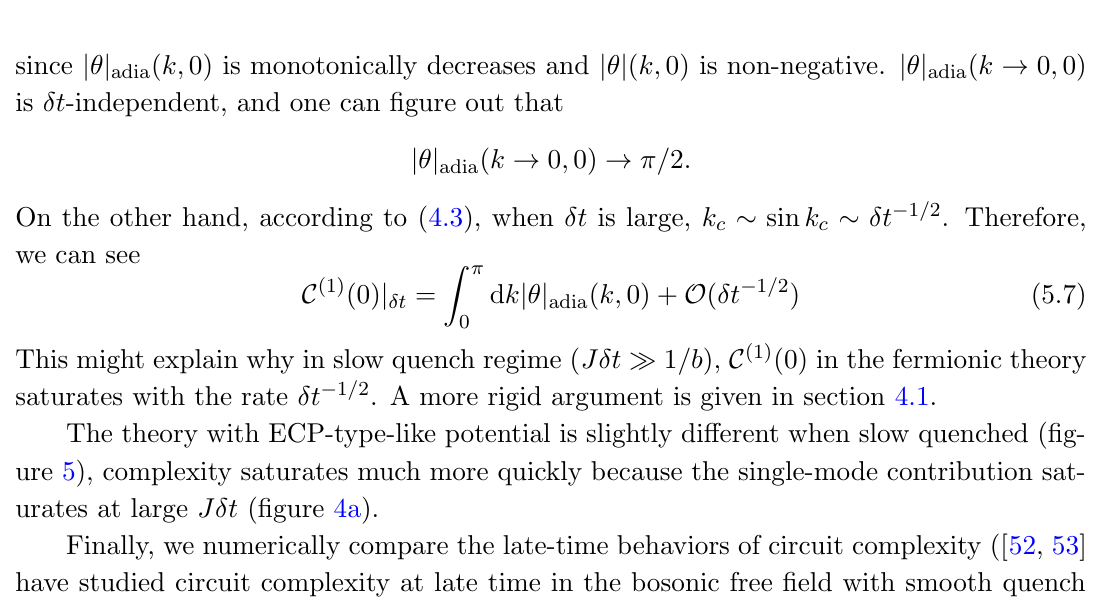
Figure 4. Single-mode contribution to complexity at t = 0, j (cid:18) j ( k; 0) in ECP and CCP-like poten- tials when b = 0 : 01. Purple, red, yellow, green and blue solid lines are J(cid:14)t = 0 : 01 ; 0 : 1 ; 1 ; 10 ; 100,